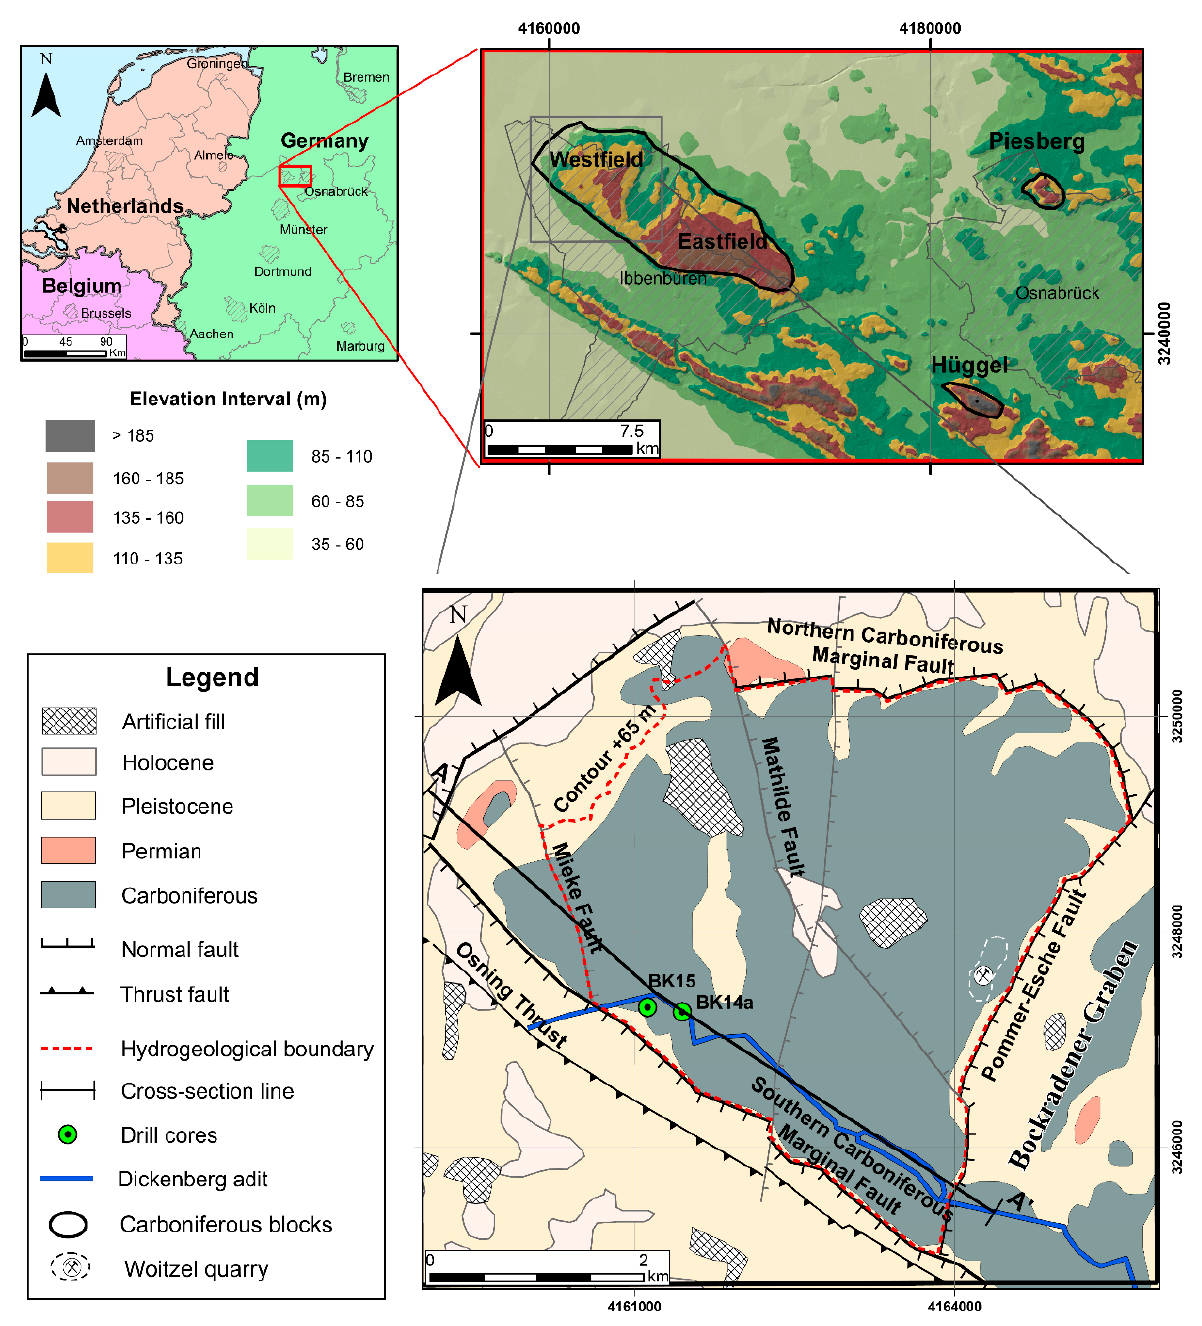
Figure 1. Geographic and geological maps of the studied area. The polygons enclosed by the thick black line in the digital elevation image additionally illustrate the location of the other two Carboniferous blocks in the surrounding area. The A-A’ line denotes the position of the cross-section in Figure 2. Modified after [10,35,36].